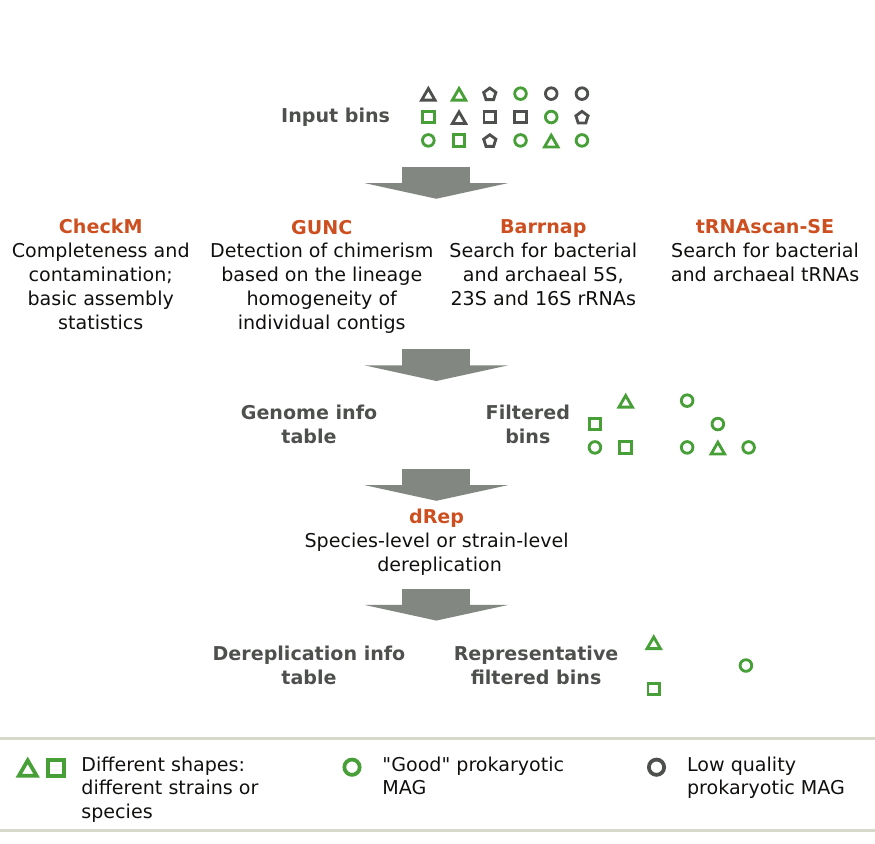
Figure 1. Metashot/prok-quality workflow. The workflow takes a series of genomes (input bins) in FASTA format and returns: i) a tab-separated values (TSV) file including, for each input genome, the quality information recom- mended by the MIMAG standard (genome info table); ii) a directory containing the bins filtered according the completeness and contamination thresholds; iii) a TSV file listing the cluster membership of each genome after